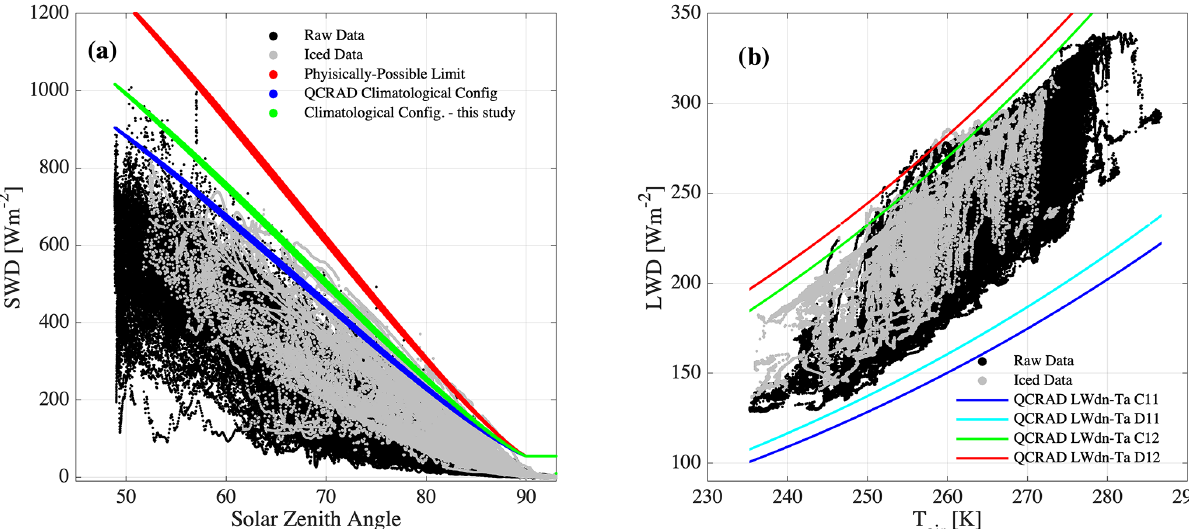
Figure 2. Examples of climatological configurable limit tests from Long and Shi (2008) for SWD (SN F16305R) (a) and LWD (SN 28507) (b) . The figures are comparable to Figs. 1 and 9 from Long and Shi except that 1min averages are shown here instead of 15min. Black points are ice-free, and grey points are contaminated with ice. The colored lines are suggested thresholds for rejection of data of varying degrees of